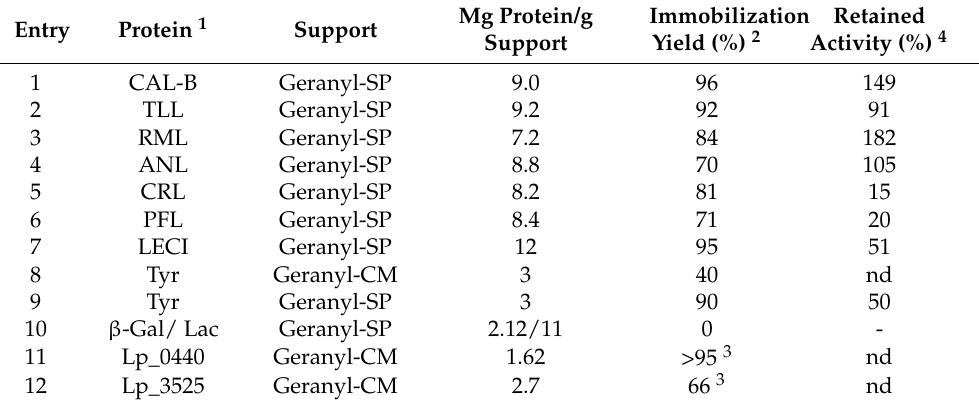
Table 1. Immobilization of enzymes on geranyl support at pH 7 buffer phosphate 25